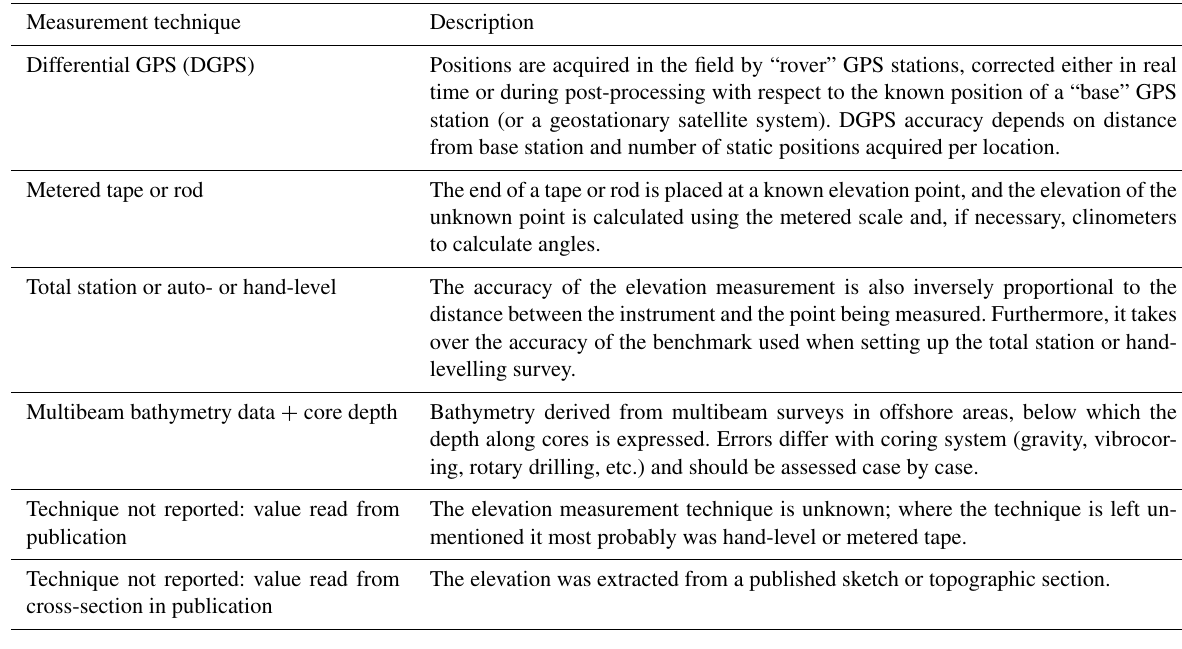
Table 5. Techniques to establish present elevation.